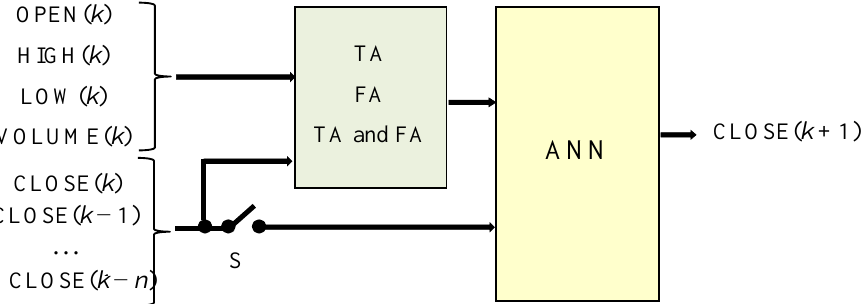
Figure 1. Processing scheme for one-day ahead predicting of the CLOSE value using hybrid TA–FA–ANN-based approach. TA = Technical analysis, FA = Fractal analysis, ANN = Artificial neural network.